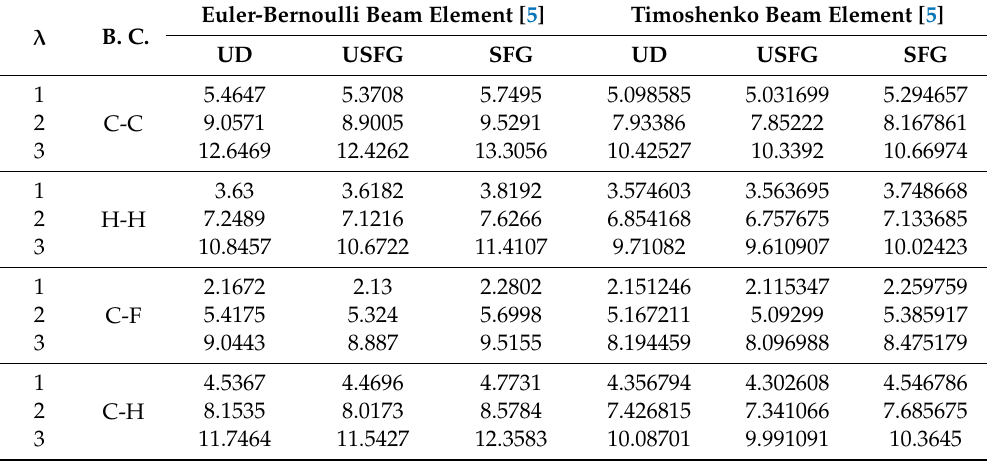
Table 5. Natural frequencies in order of the material distribution and boundary conditions.